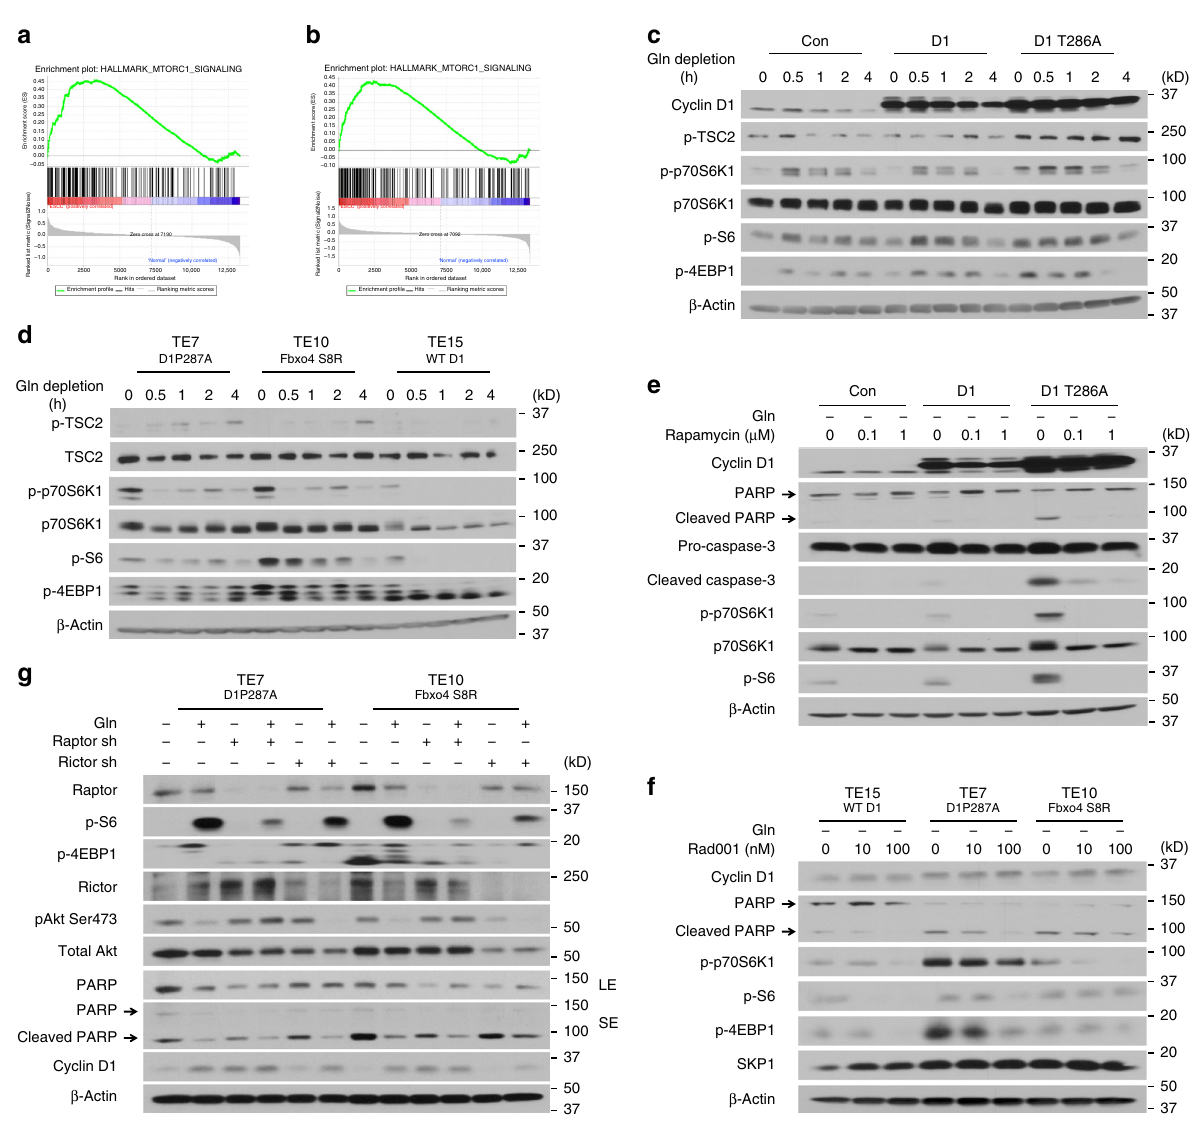
Fig. 3 mTORC1 contributes to Gln-addiction in cells with dysregulated cyclin D1. a, b Gene set enrichment analysis (GSEA) enrichment plots for expression pro fi les of esophageal squamous cell carcinoma (ESCC) versus normal tissues for gene sets correlated to mTORC1 signaling in NCBI GEO datasets: a GSE100942 — NES = 1.4599689, FDR q -val = 0.12097056 and b GSE20347 — NES = 1.269795, FDR q -val = 0.3669077. c Western blot for the indicated mTORC1 effectors in NIH3T3 cells expressing cyclin D1 or D1T286A. d Western blot analysis for mTORC1 effectors in TE7, TE10, and TE15 cells. e Rapamycin compromises mTORC1 activation and apoptosis induced by ectopic cyclin D1 expression in NIH3T3 cells upon 24 h Gln-depletion. f Rad001 inhibits mTORC1 activation and apoptosis in TE7 and TE10 cells upon 24 h Gln-depletion. g Raptor knockdown suppresses apoptosis in TE7 and TE10 cells upon 24 h Gln-depletion. SE: short exposure; LE: long exposure. Arrow: speci fi c Supplementary Fig. 7b). To test whether cyclin D1 is suf fi cient to drive cellular Gln-dependency, cyclin D1 or D1T286A (a stable oncogenic D1 mutant analogous to D1P287A), were ectopically expressed in TE15 cells. D1T286A expression drove apoptosis of TE15 cells cultured in Gln-free medium (Fig. 2f and Supplemen- tary Fig. 7c). TE1 cells are Rb de fi cient, resulting in the bypass of cell cycle control that depends on cyclin D1-CDK4/6 complex 29,30 ; Rb loss compromised cyclin D1 expression, but drove the sensitivity to Gln restriction (Fig. 2g, h). Likewise, Rb knockdown promoted Gln-addiction in TE15 cells that mimics the fi ndings in TE1 cells (Supplementary Fig. 7d, e). Taken together, these data reinforce the role of Fbxo4-cyclin D1 axis in driving Gln- addition in ESCC cells, and Rb is an important contributing factor.